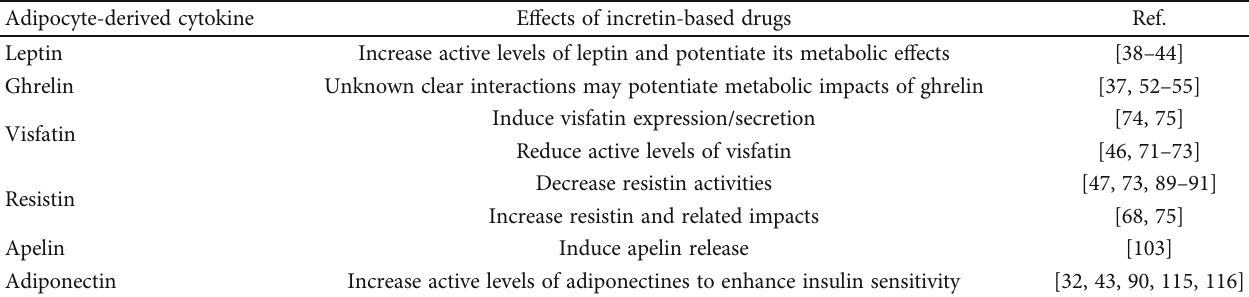
Table 2: current knowledge on e ff ects of incretin-based antidiabetic drugs on adipokines and adipocyte-derived cytokines. Adipocyte-derived